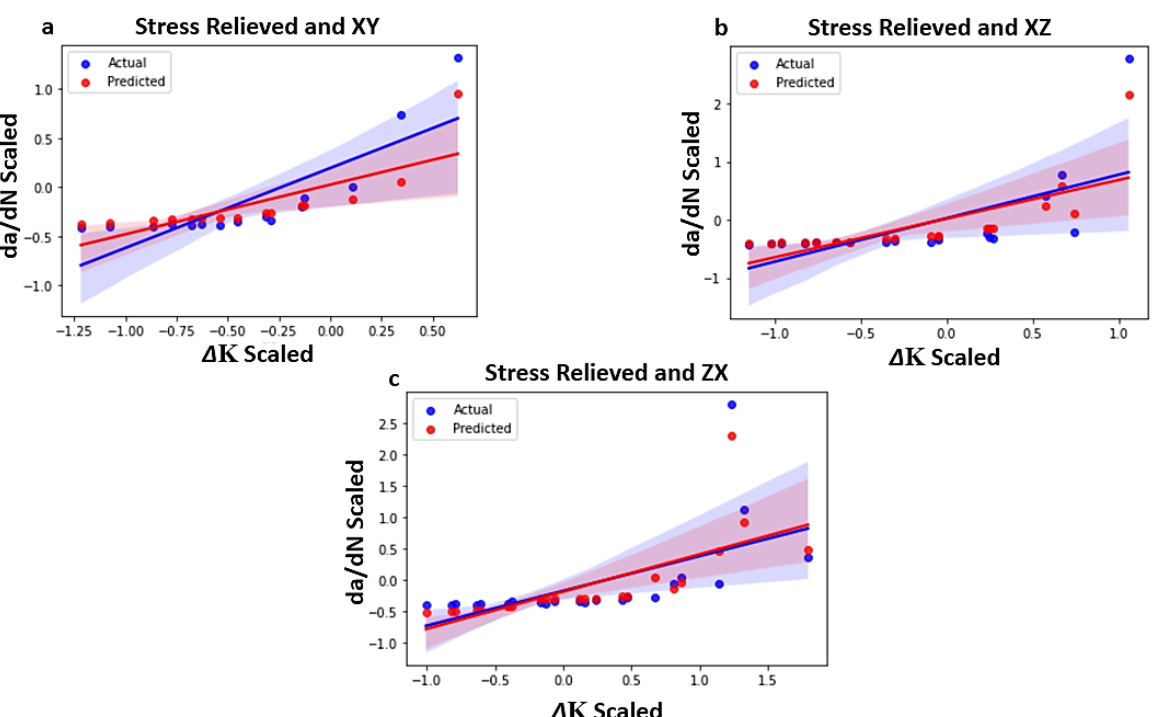
Figure 5. Actual and Prediction Plots for Stress Relieved Samples of Ti-64 alloy ( a ) XY Specimen Orientation; ( b ) XZ Specimen Orientation and ( c ) ZX Specimen Orientation.